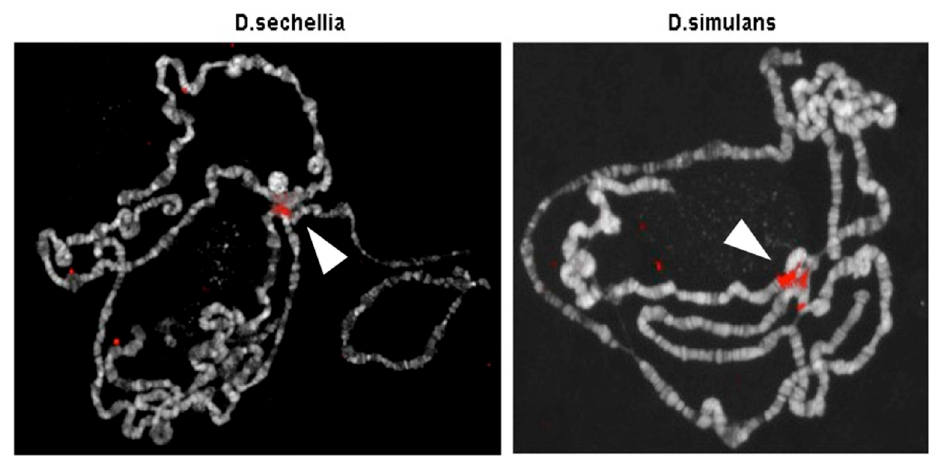
Figure 2. The distribution of the Doc5 transposon was analyzed by FISH in the genome of D. sechellia ( left panel ) and D. simulans ( right panel ), two species closely related to D. melanogaster . The Doc5 fragment cloned from the h39 region (596bp sequence) was used as probe. Arrowheads point to the chromocenter.